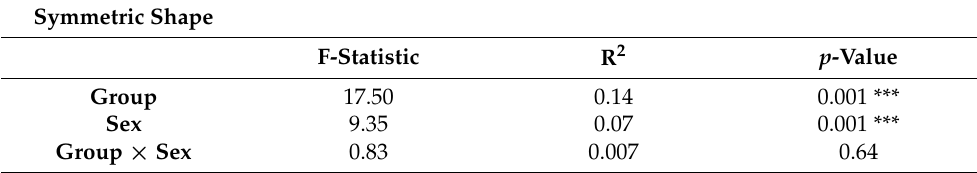
Table 3. Results of the Multivariate Procrustes ANOVA between the dependent variable of symmetric shape and the independent variables of “group” (wild and captive) and “sex” and their interaction.